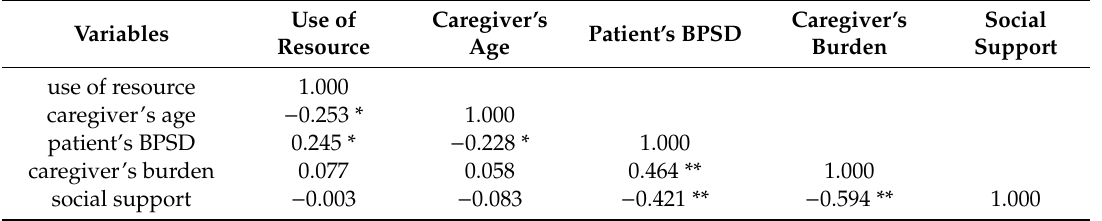
Table 5. Factors correlated to the frequency of long-term care service resource utilization: Pearson’s correlation